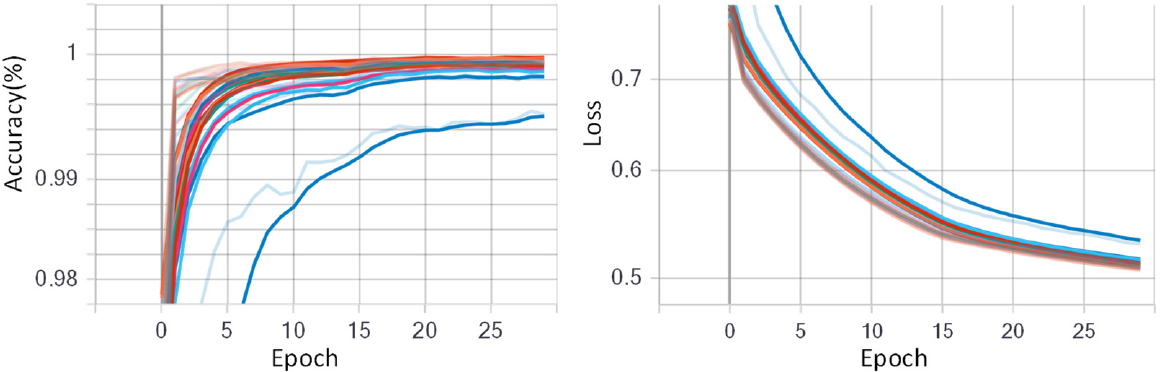
Figure 10. Training progress of fine-tuned GAF-CNN model for high-density dataset CapgMyo DB-a. The epoch number was set to 30 and different colors denote the 18 different subjects. The different color lines indicate different subjects.